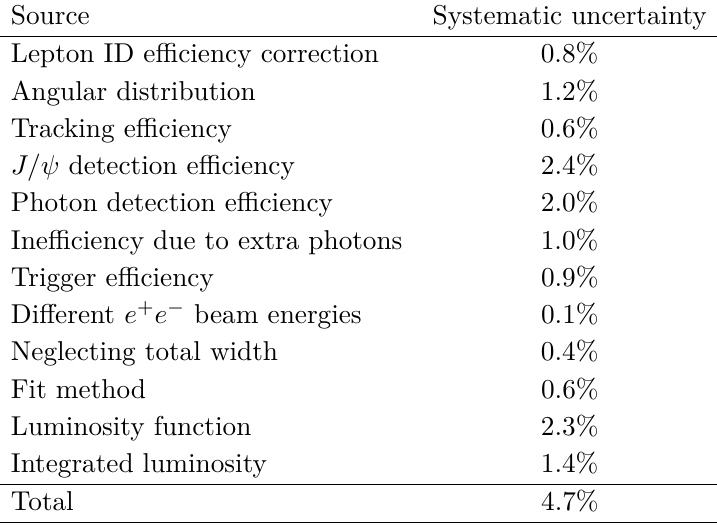
Table 1 . Summary of the systematic uncertainties for Γ γγ ( χ c 2 (1 P ))